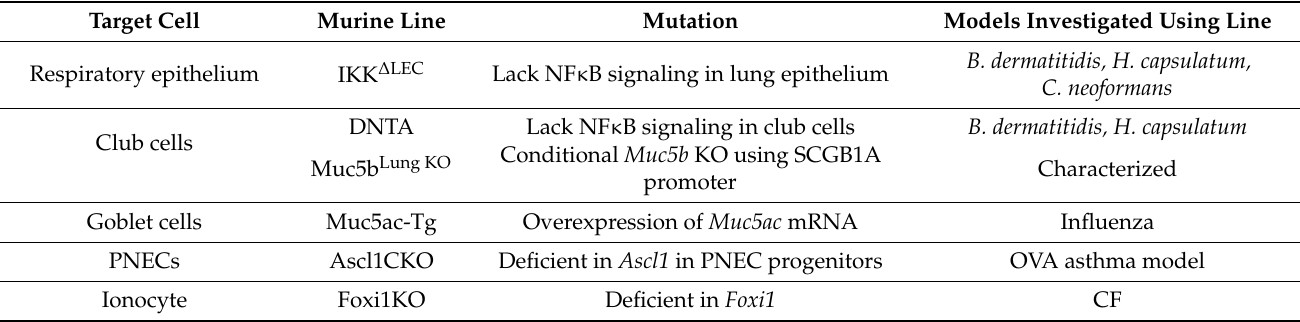
Table 2. Transgenic murine models targeting respiratory epithelial cell subtypes. Target